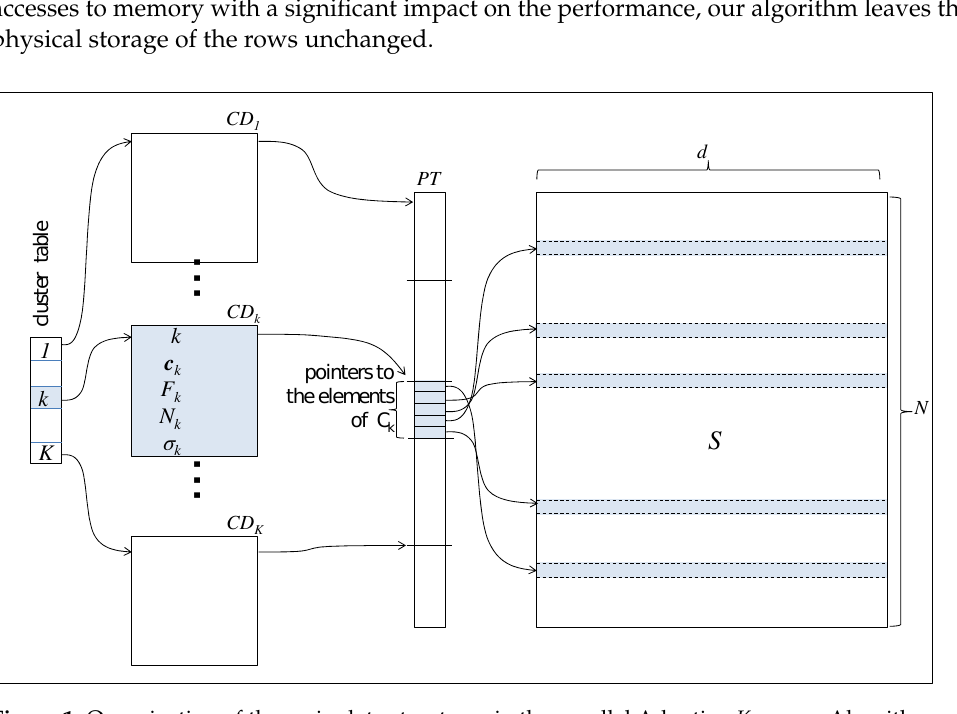
Figure 1. Organization of the main data structures in the parallel Adaptive K -means Algorithm. For accessing the elements in the array S , the algorithm then uses a pointers array PT , where contiguous items point to the elements of the same cluster. With this structure at hand, Algorithm 2, in step 2.4.3, can displace the elements only acting on the array PT with a cost of O ( 1 ) memory